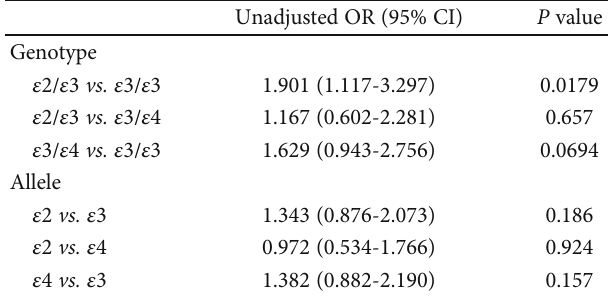
Table 3: Associations of APOE gene polymorphisms and the risk of IS in T2DM patients compared to that in case patients, represented as unadjusted OR.